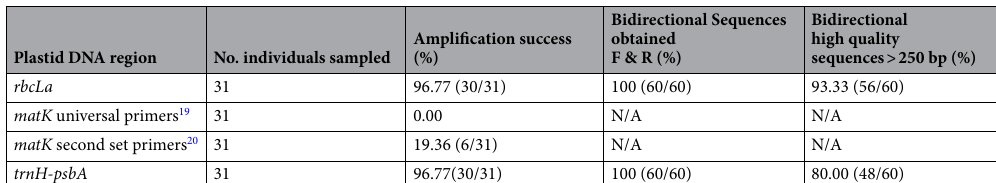
Table 3. Proportion of samples successfully amplified and sequenced from three barcoding plasmid regions using tissues from different species of ferns and lycopods of the Mixteca Alta, Oaxaca, Mexico.